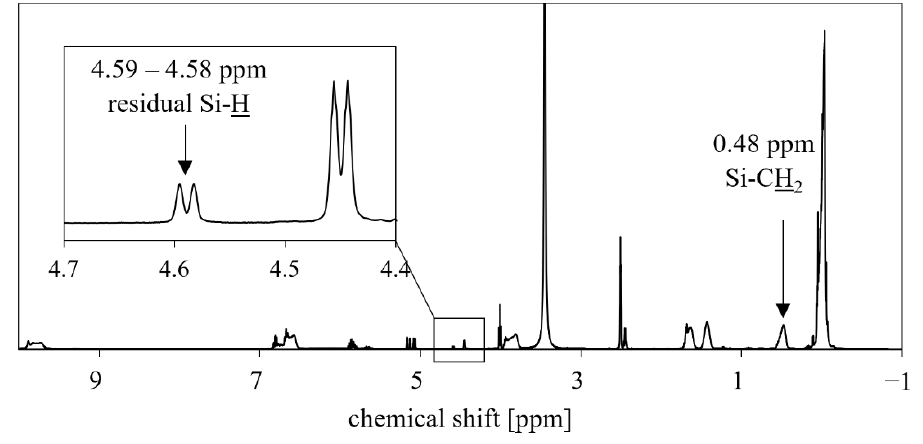
Figure 6. 1 H-NMR spectrum of PMFOS.